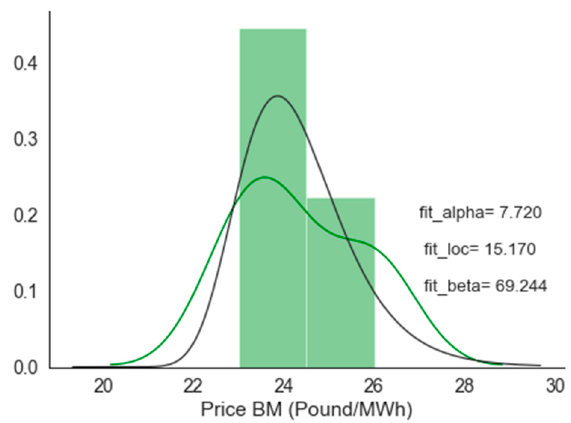
Figure 4. Alpha statistical distribution with parameters.